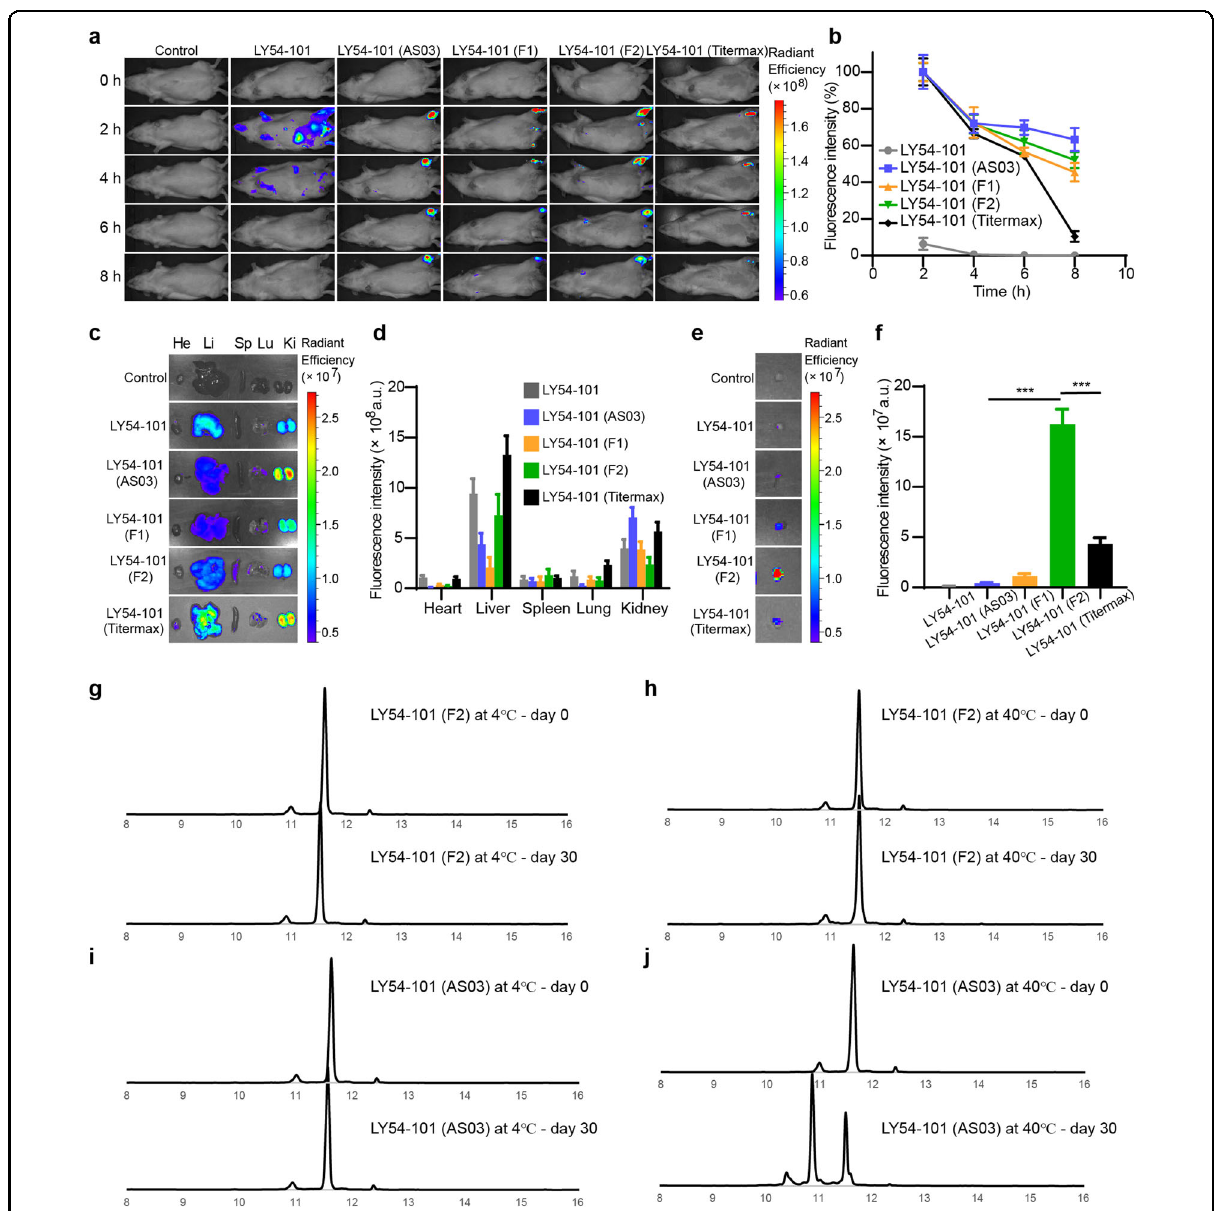
Fig. 3 Biodistribution and retention of peptide vaccine nanoemulsions in vivo. a Real-time in vivo fl uorescence images of rats after intramuscular injection of Cy5-labeled LY54 – 101 nanoemulsions. b Monitoring of the kinetics of LY54 – 101 nanoemulsion retention at injection sites within 8 h. ( n = 3; means ± SD). c , d Biodistribution of Cy5-labeled LY54 – 101 nanoemulsions in main organs excised from rats at 8 h post injection. ( n = 3; means ± SD). c Fluorescence images of organs. d Fluorescence intensity analysis. He, hearts; Li, livers; Sp, spleens; Lu, lungs; Ki, kidneys. e , f Fluorescence images ( e ) of lymph nodes excised at 8 h post injection and fl uorescence intensity analysis ( f ) of Cy5-labeled LY54 – 101 nanoemulsions. ( n = 3; means ± SD), *** P < 0.001 as determined by one-way ANOVA with multiple comparison tests. g – j HPLC pro fi le of stability analysis of F2 nanoemulsion formulation ( g , h ) and AS03 nanoemulsion formulation ( i , j ) for LY54 – 101 at 4 °C or 40 °C for 30 days. The horizontal axis represents the retention time (min), and the vertical axis represents the absorbance